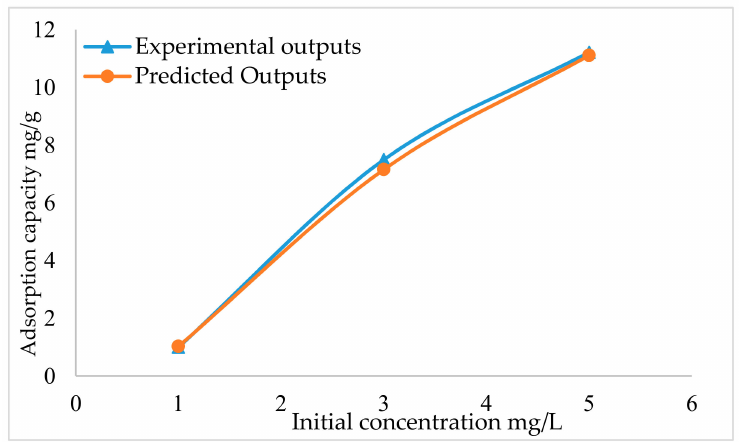
Figure 2. E ff ect of initial concentration on adsorption